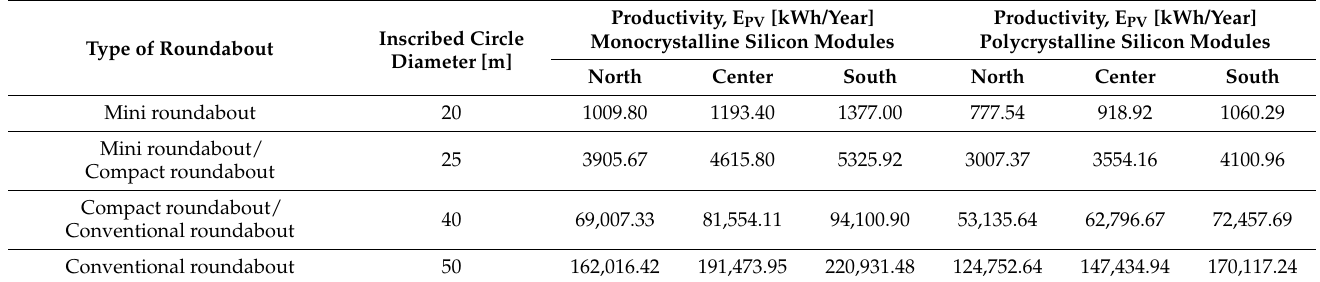
Table 5. Electricity productivity of the RAPS (E PV